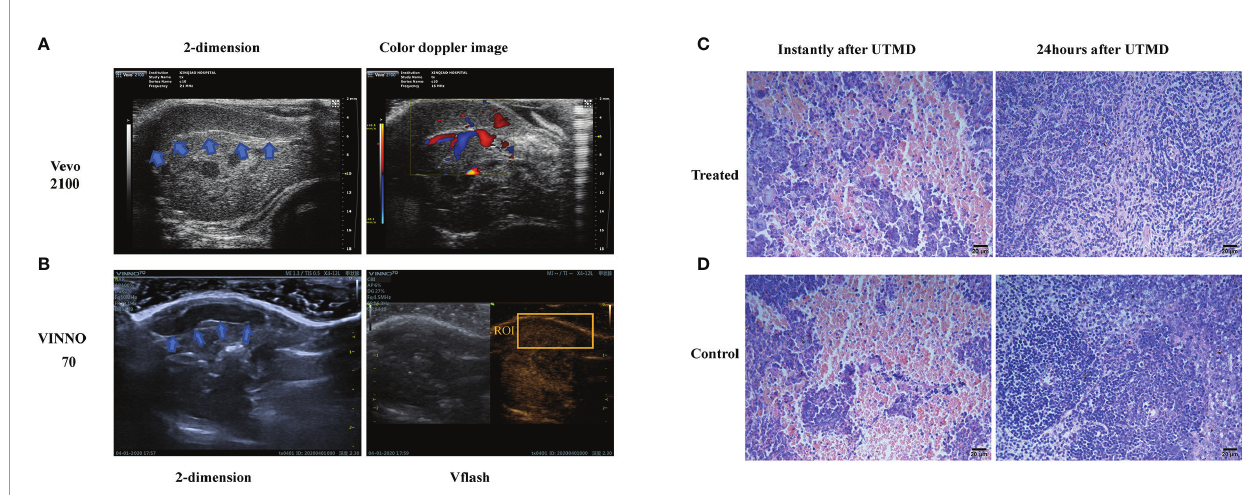
FIGURE 1 | The sonography and microscopy observation of the tumor-bearing mouse spleen. (A) The two-dimensional and color Doppler fl ow images of the tumor-bearing mouse spleen (shown in blue arrows) with a small animal ultrasound system (Vevo2100, USA). (B) The two-dimensional and contrast-enhanced ultrasound sonography on the diagnostic – therapeutic ultrasonic apparatus VINNO 70 (VINNO Technology Co. Ltd, Suzhou, China). The region of interest (ROI) is shown by the orange box. Respective H&E-dyed slice observation of the tumor-bearing mice instantly and 24 h after ultrasound-targeted microbubble destruction (UTMD) treatment in treated (C) and control (D)